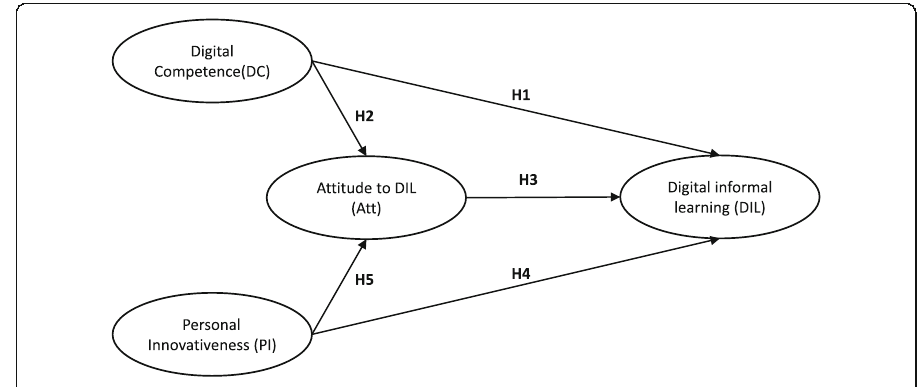
Fig. 1 Research model of this study: factors related to